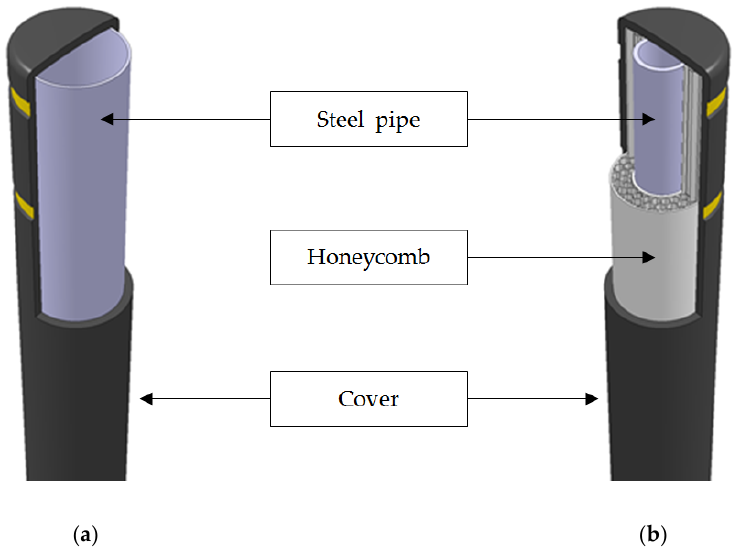
Figure 5. Comparison of internal structure: ( a ) Conventional steel bollard; ( b ) Bollard with Honeycomb.